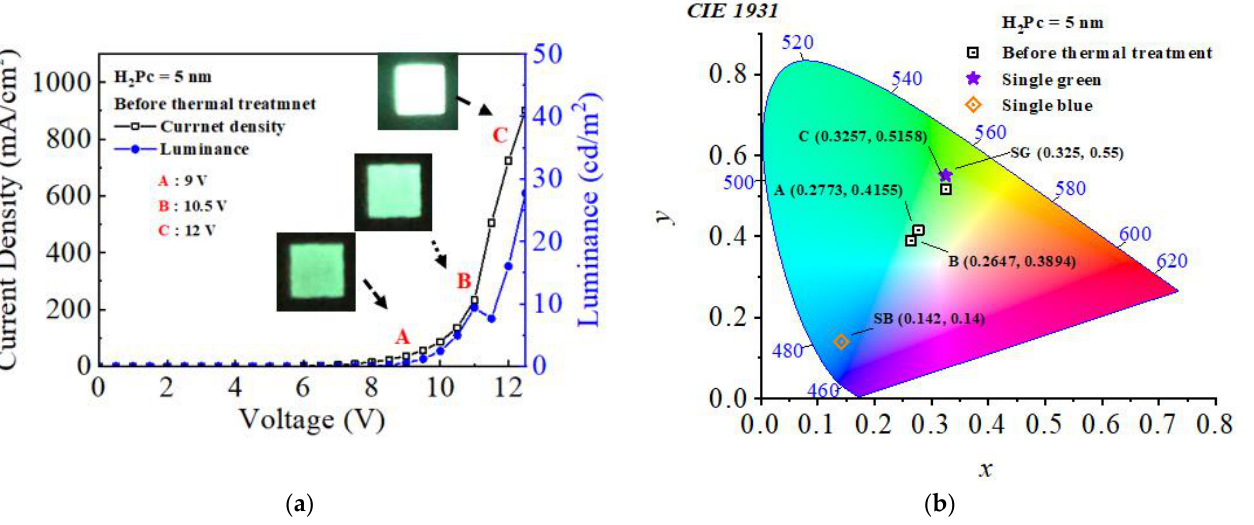
Figure 3. ( a ) Current density ( J ), voltage ( V ), and luminance ( L ) characteristics and ( b ) CIE coordinates of the CTOLED before thermal